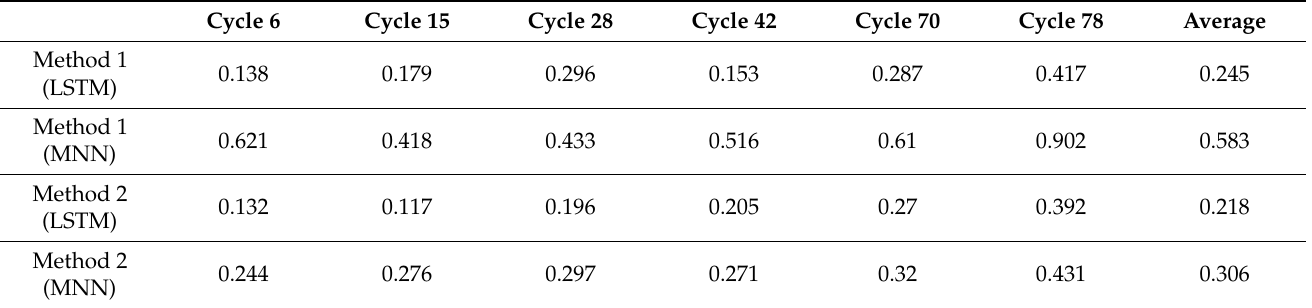
Table 4. SOC estimation error for each model using the Oxford battery dataset.